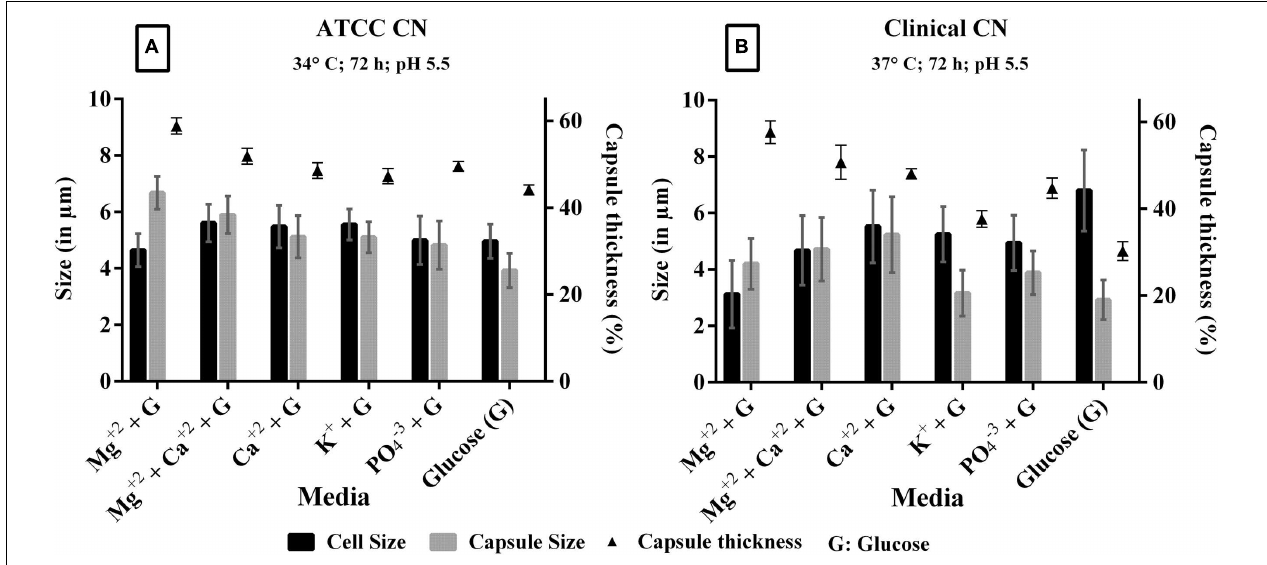
FIGURE 5 | Effect of ACSF salts [Magnesium (Mg 2 + ), Calcium (Ca 2 + ), Potassium (K + ), Phosphate (PO 43 − ) salts were supplemented with 0.1% glucose] on capsule induction in (A) ATCC C. neoformans at 34 ◦ C, 72 h, pH 5.5; (B) clinical C. neoformans at 37 ◦ C, 72 h, pH 5.5. 0.1% glucose used as a control. Left Y -axis represents size (in µ m) for cell and capsule, compared with capsule thickness (%) through right Y -axis. The cell size, capsule size, and percentage of the capsule thickness for ≥ 8 cells per group are shown. Bars represent standard errors ( p < 0.0001); G,